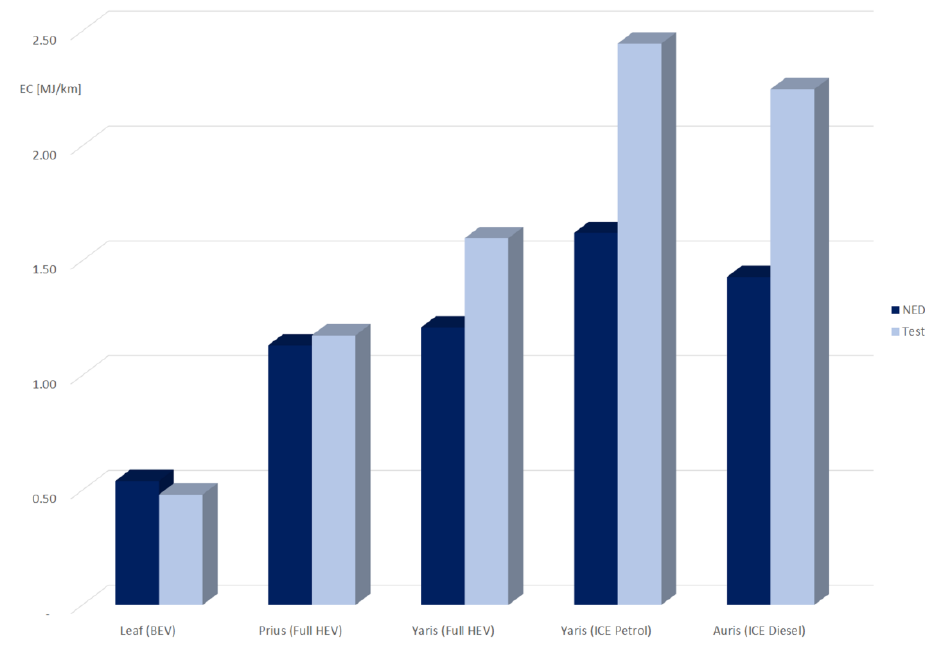
Figure 16. Comparison between test and NECD energy consumption.